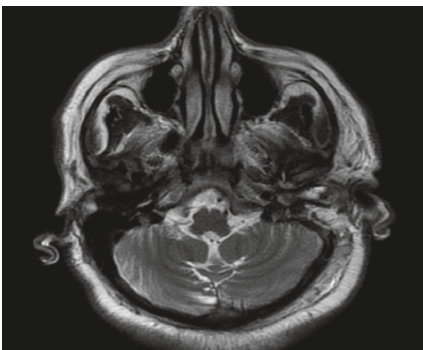
Figure 4: MRI of cerebellopontine angles and posterior fossa (axial cut). Opacification of the left mastoid air cells and middle ear cavity with soft tissue signal which elicits low signal in T1WI and high signal in T2WI with restricted diffusion in DWI. There is ho- mogeneous enhancement following IV contrast administration. No evidence of adjacent intracranial abscess formation or sinus thrombosis. The region of brain stem and cerebellar hemispheres are normal. No focal lesions are seen. Both the VII and VIII cranial nerves show normal course and signal intensity. No intra- or extra- canalicular enhancing lesion is seen.